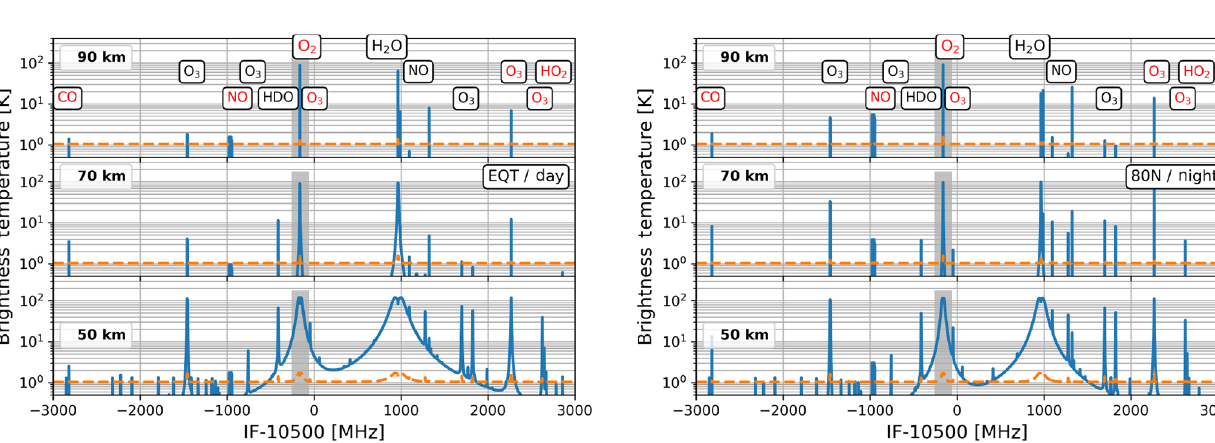
Figure 2. (a) Spectra at the Equator in daytime for tangent heights of 50, 70 and 90km. The x coordinates are the intermediate frequency (IF). The yellow dashed lines indicate the noise standard deviation (2 σ ). The grey area shows the frequency range of 200MHz in which the Zeeman radiative transfer model is used (only for the upper-side band). (b) Same as (a) but for 80 ◦ N and nighttime winter conditions. The red labels indicate molecular lines in the upper-side band. The LO frequency is 763.5GHz.